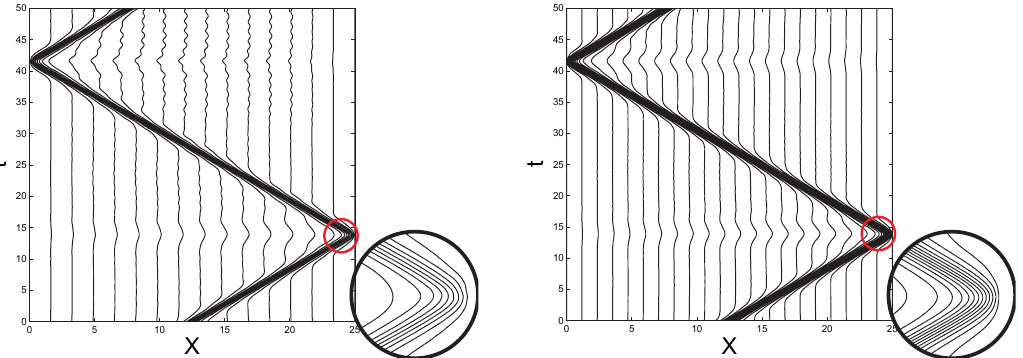
Figure 8. The mesh point trajectories (with zoomed-in insets) for the Lagrange multiplier strategy for N = 22 ( left ) and N = 31 ( right ): Integration in time was performed using the 4th-order Lobatto IIIA–IIIB scheme for constrained mechanical systems.